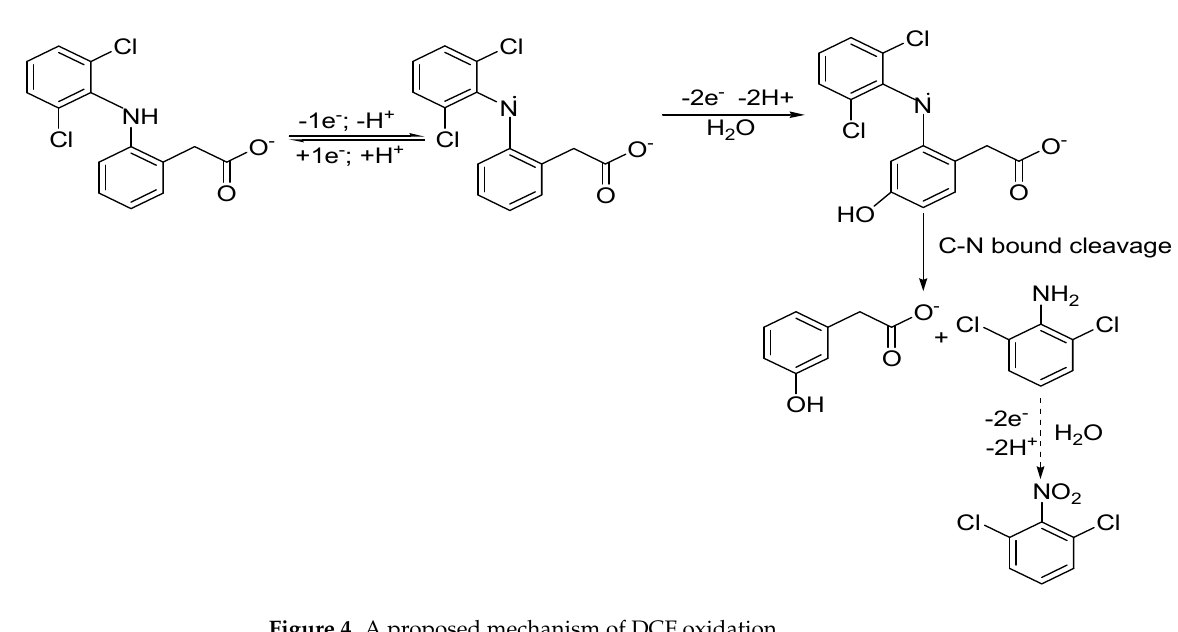
Figure 4. A proposed mechanism of DCF